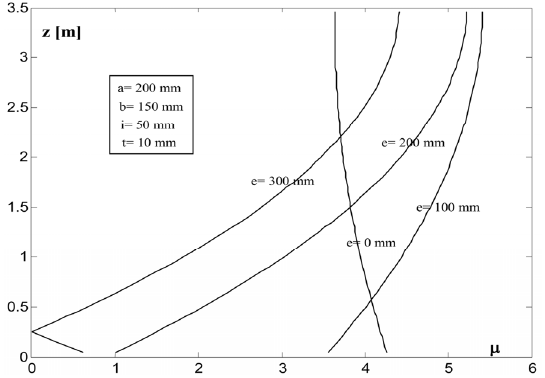
Figure 12. Model B_2: Displacement ductility requirements for steel plates at 4th step.